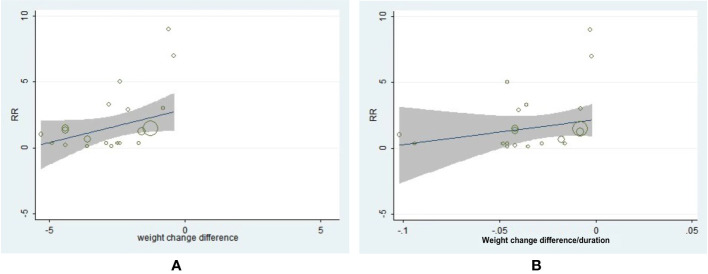
The association between weight reduction difference or change rate and the incidence of uterine neoplasm. (A) Weight reduction difference and incidence of uterine neoplasm (β = 0.8743, 95% CI, 0.2206 to 1.5280, P = 0.012). (B) Weight reduction rate and incidence of uterine neoplasm (β = 34.062, 95% CI, −6.3617 to 74.4857, P = 0.094).